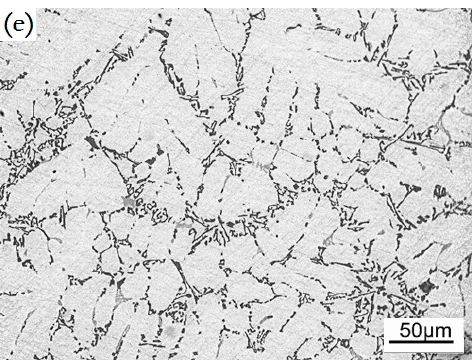
Figure 1. Microstructure of the Ho-modified A356 aluminum alloys in as-cast state, ( a ) unmodified; ( b ) 0.1 wt.%; ( c ) 0.2 wt.%; ( d ) 0.3 wt.%; ( e ) 0.4 wt.%.